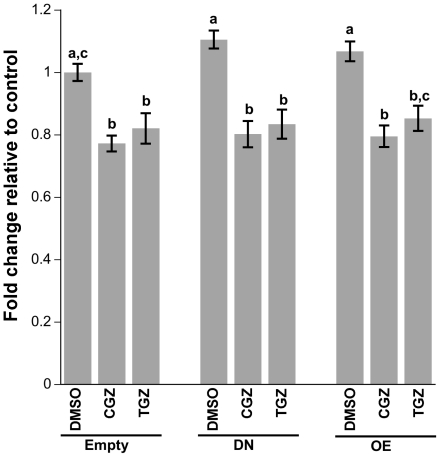
Effect of CGZ and TGZ treatment on Ovcar3 cell proliferation in cells transfected with DN or OE PPARγ constructs.Ovcar3 cells were double transfected, serum starved for 24 hours and treated for an additional 24 hours with vehicle control (DMSO) or10 µM of CGZ or TGZ. Cell proliferation was assessed with a BrdU assay. Results are the means ± SEM for at least 9 measurements from three individual experiments. Bars that do not share a letter designation are significantly different within a treatment group (p<0.05).